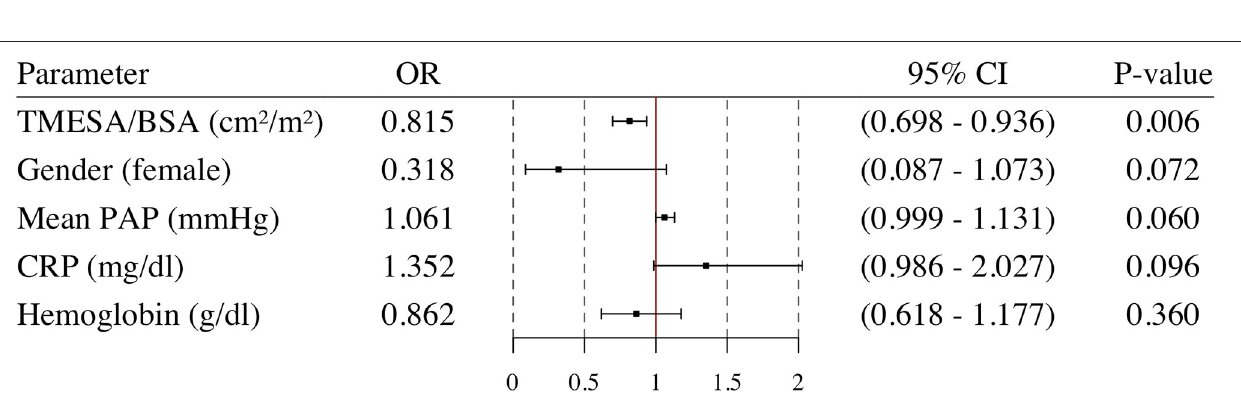
FIGURE 8 | Multivariable logistic regression analysis. Odds ratio and 95% confidence interval calculated in a multivariable logistic regression analysis for TMESA/BSA adjusted for Gender, mean PAP, CRP and hemoglobin. Endpoint: death or emergency VAD implantation during the HU waiting time. VAD, ventricular assist device; TMESA/BSA, total area of the erector spinae muscles/body surface area; PAP, pulmonary artery pressure; CRP, C-reactive protein; HU, high urgent.